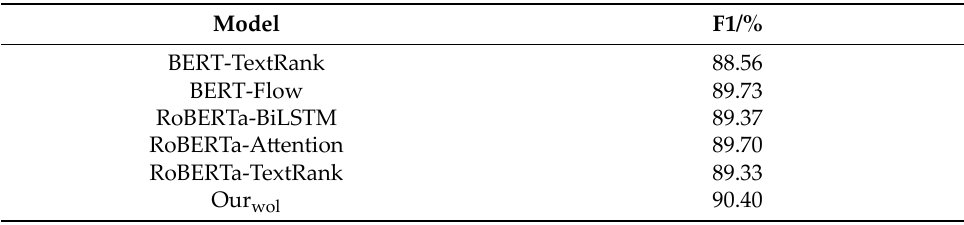
Table 6. Experimental results on CCKS2019 dataset.